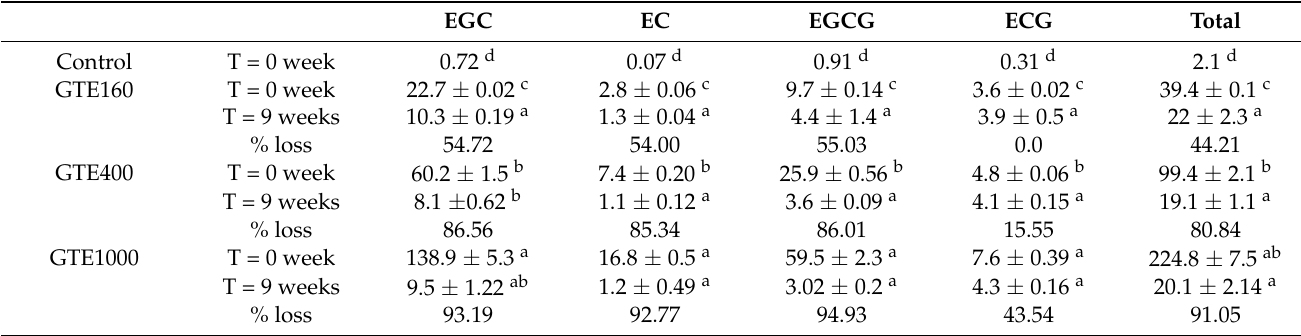
Table 3. Catechin content ( µ g/g) of DHA-rich oil supplemented with green tea extract after 9 weeks of storage at 30 ◦ C.